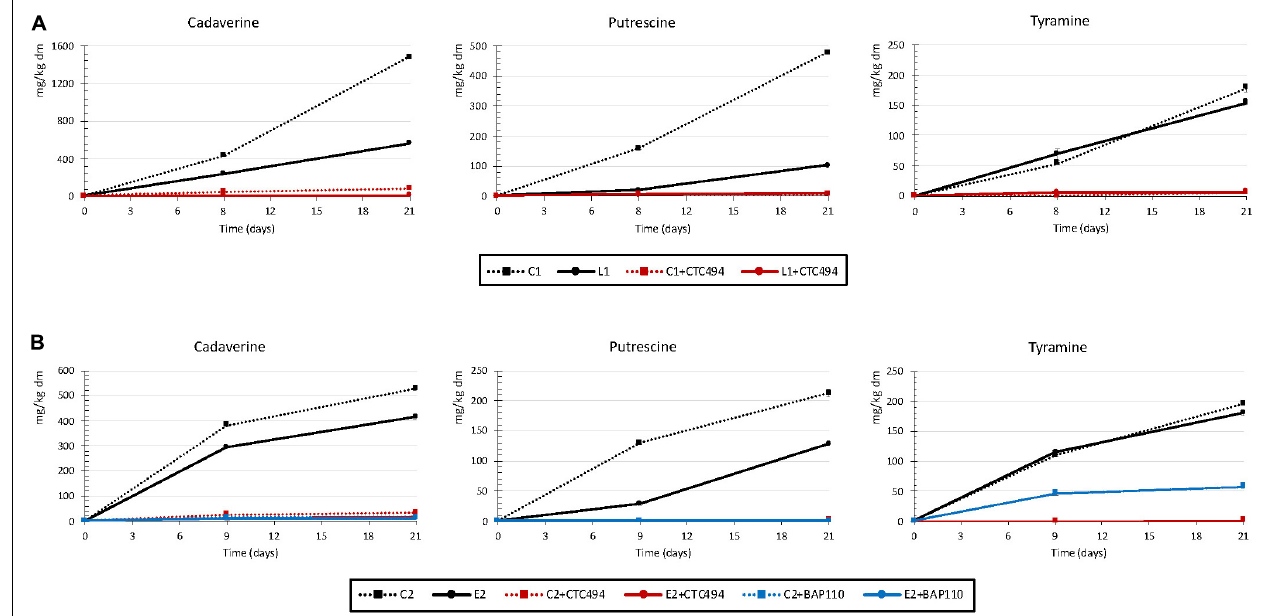
FIGURE 1 | Contents of cadaverine, putrescine, and tyramine (mg/kg dry matter) in fermented sausages: (A) Spontaneous fermentation without (C1) or with (L1) the addition of 5% cava lees or fermentation with the starter culture L. sakei CTC494 without (C1 + CTC494) or with (L1 + CTC494) cava lees; (B) Spontaneous fermentation without (C2) or with (E2) the addition of 0.3% LPE or fermentation with the starter culture L. sakei CTC494 or L. sakei BAP110 without (C2 + CTC494 or C2 + BAP110) or with (E2 + CTC494 or E2 + BAP110) the LPE.